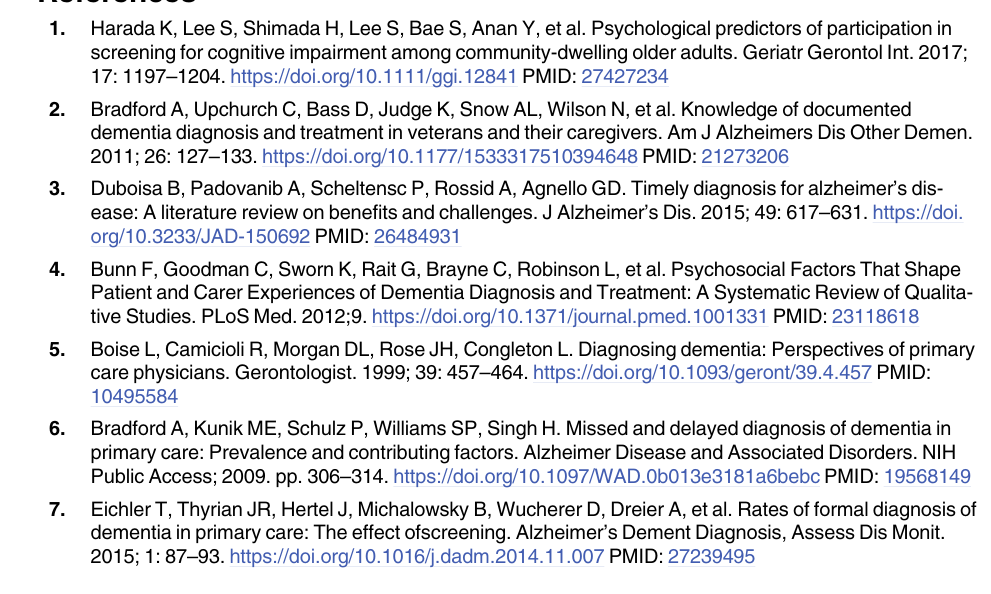
S2 Table. Descriptive statistics of demographic and vocal data for each group on audio file